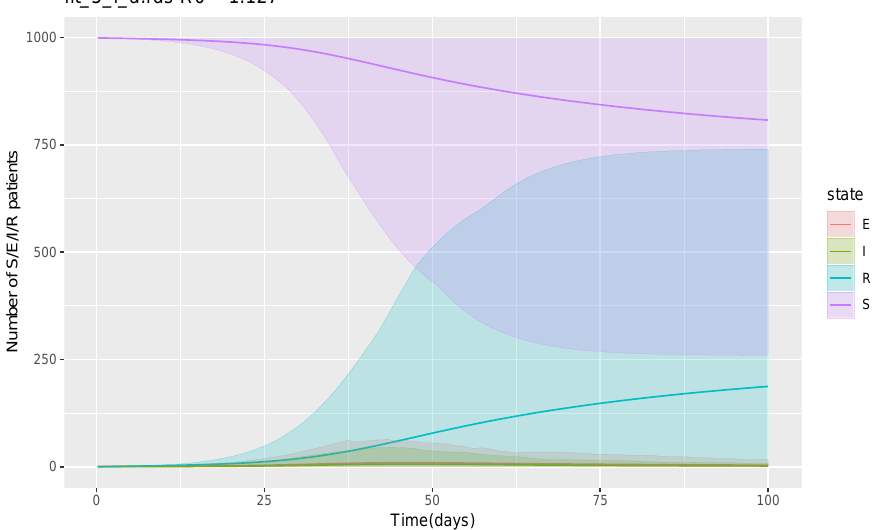
Figure 4. SEIR model with β of 0.8–1.0 but with δ of 1 / 4–1 / 2, and ν of 1 / 2–1. Abbreviations S = susceptible, E = exposed, I = infected, and R = recovered and